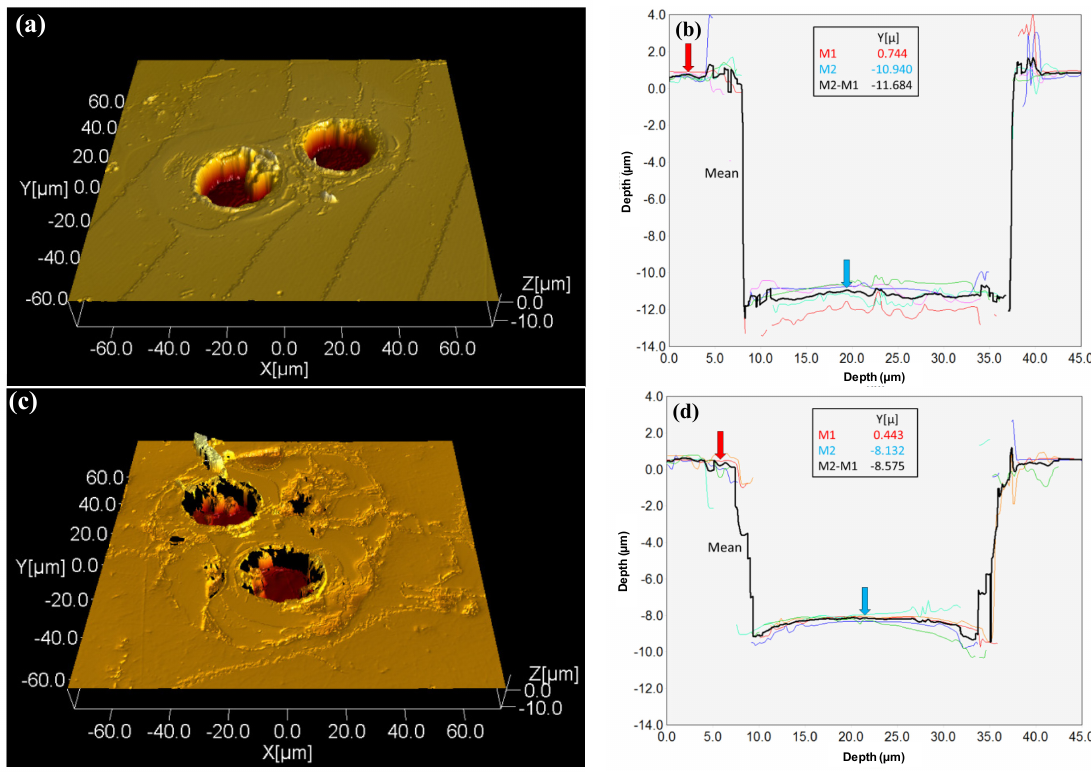
Figure 2. Ablation pit profiles from sample TSUPB021: ( a ) 3D view of untreated zircons; ( b ) cross-sectional view of untreated zircons; ( c ) 3D view of chemically abraded zircons; and ( d) cross-sectional view of chemically abraded zircons.